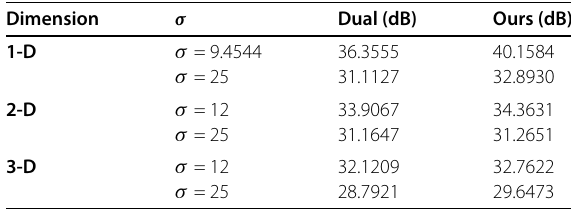
Table 2 PSNR results of Chambolle’s dual method and our new method